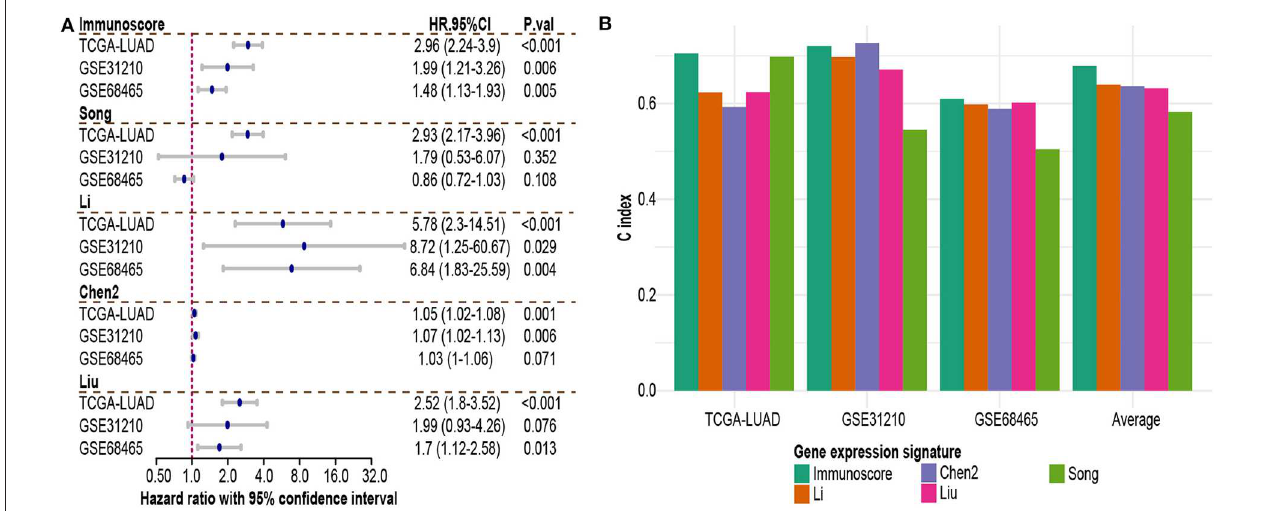
FIGURE 7 | Kaplan–Meier survival analysis and compare C-index of ICPS with immunoscore and stage in (A) training set, (B) testing set 1, (C) testing set 2, (D) meta-set.